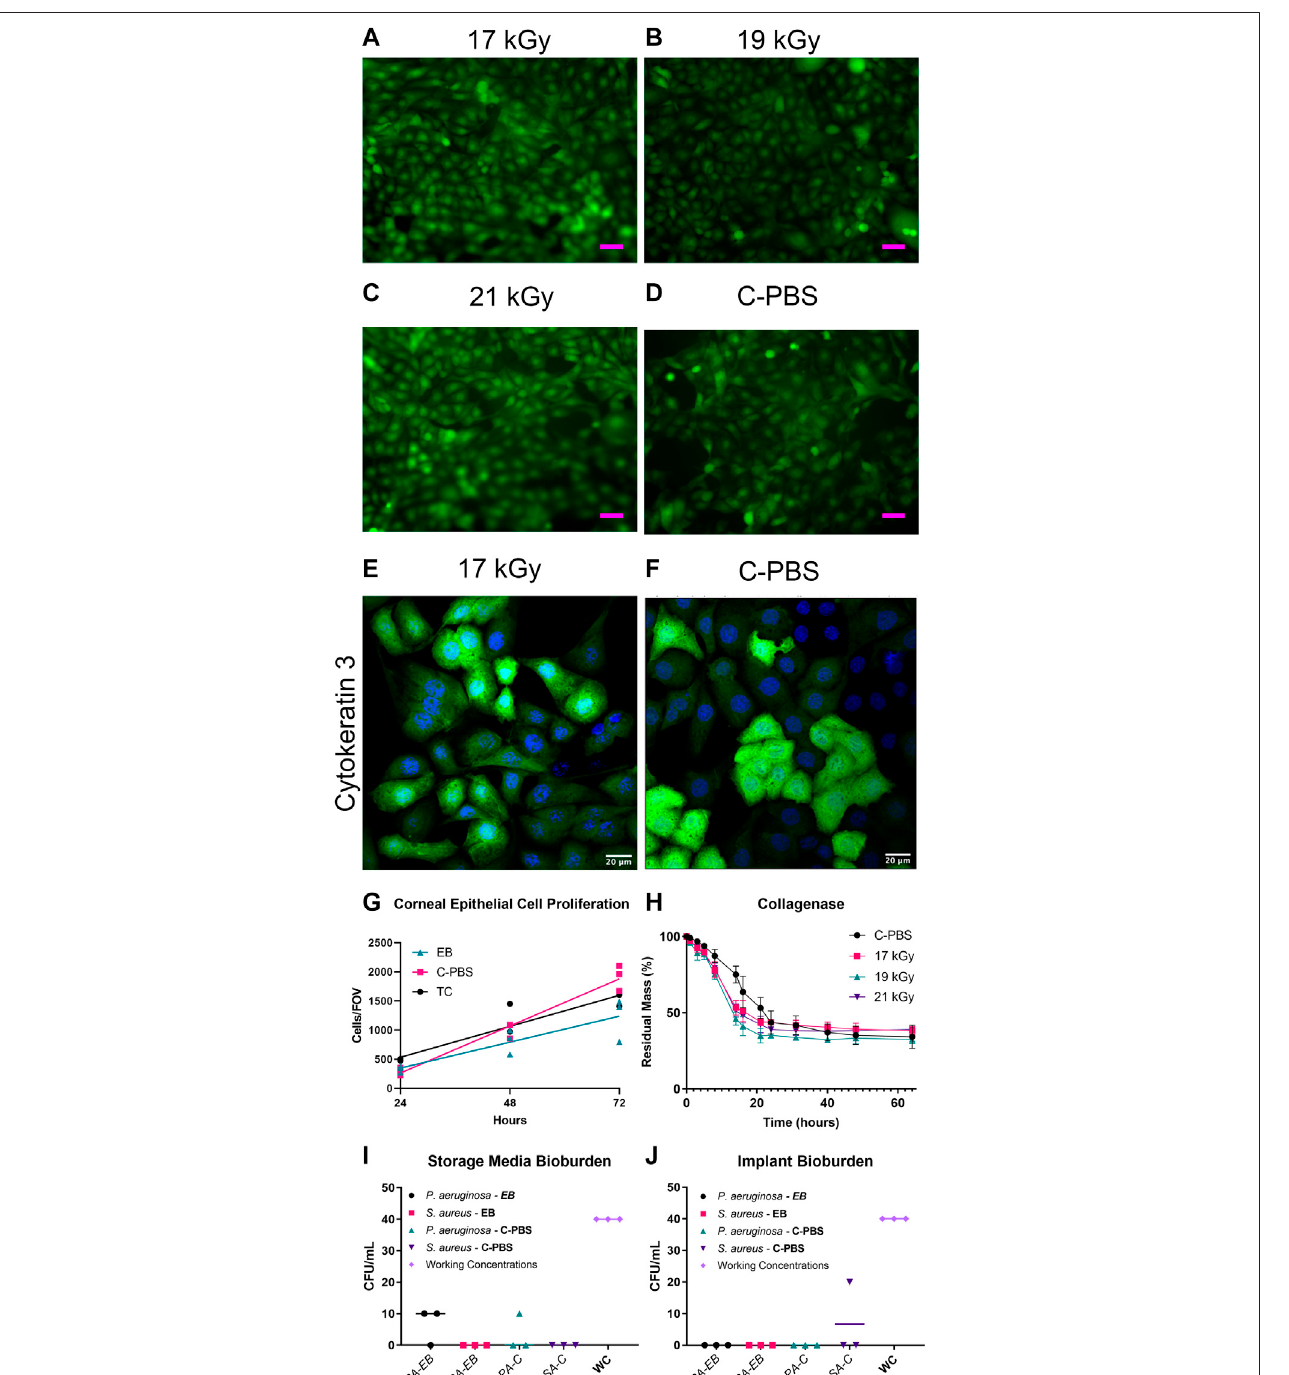
FIGURE 1 | GFP-HCEC cells on e-beam irradiated and unirradiated RHCIII-MPC implants showed con fl uence by day 4 in all cultures. (A) 17 kGy, (B) 19 kGy, (C) 21 kGy, (D) Unirradiated (C-PBS) ( n = 4, all groups). HCECs cultures on 17 kGy e-beamed samples (E) compared to C-PBS treated hydrogels (F) showed similar cytokeratin 3 staining. (G) Quanti fi cation of corneal epithelial cell proliferation on implants that have been e-beamed, stored in C-PBS, or on tissue culture (TC) plastic. Linesshowlinearregressionofthedata. (H) Collagenasedegradationofthee-beamedmaterialsdemonstratingthate-beamchangedtheratebutnottheextentof collagenase degradation of irradiated E-beamed RHCIII-MPC ( n = 4, all groups). Post-e-beam bioburden measured in the storage media in the P. aeruginosa and S. aureus -spiked implants (I) and direct culture of the corneal implants (J) showed a signi fi cant reduction from the 400 CFU/ml ( n = 4, all groups).